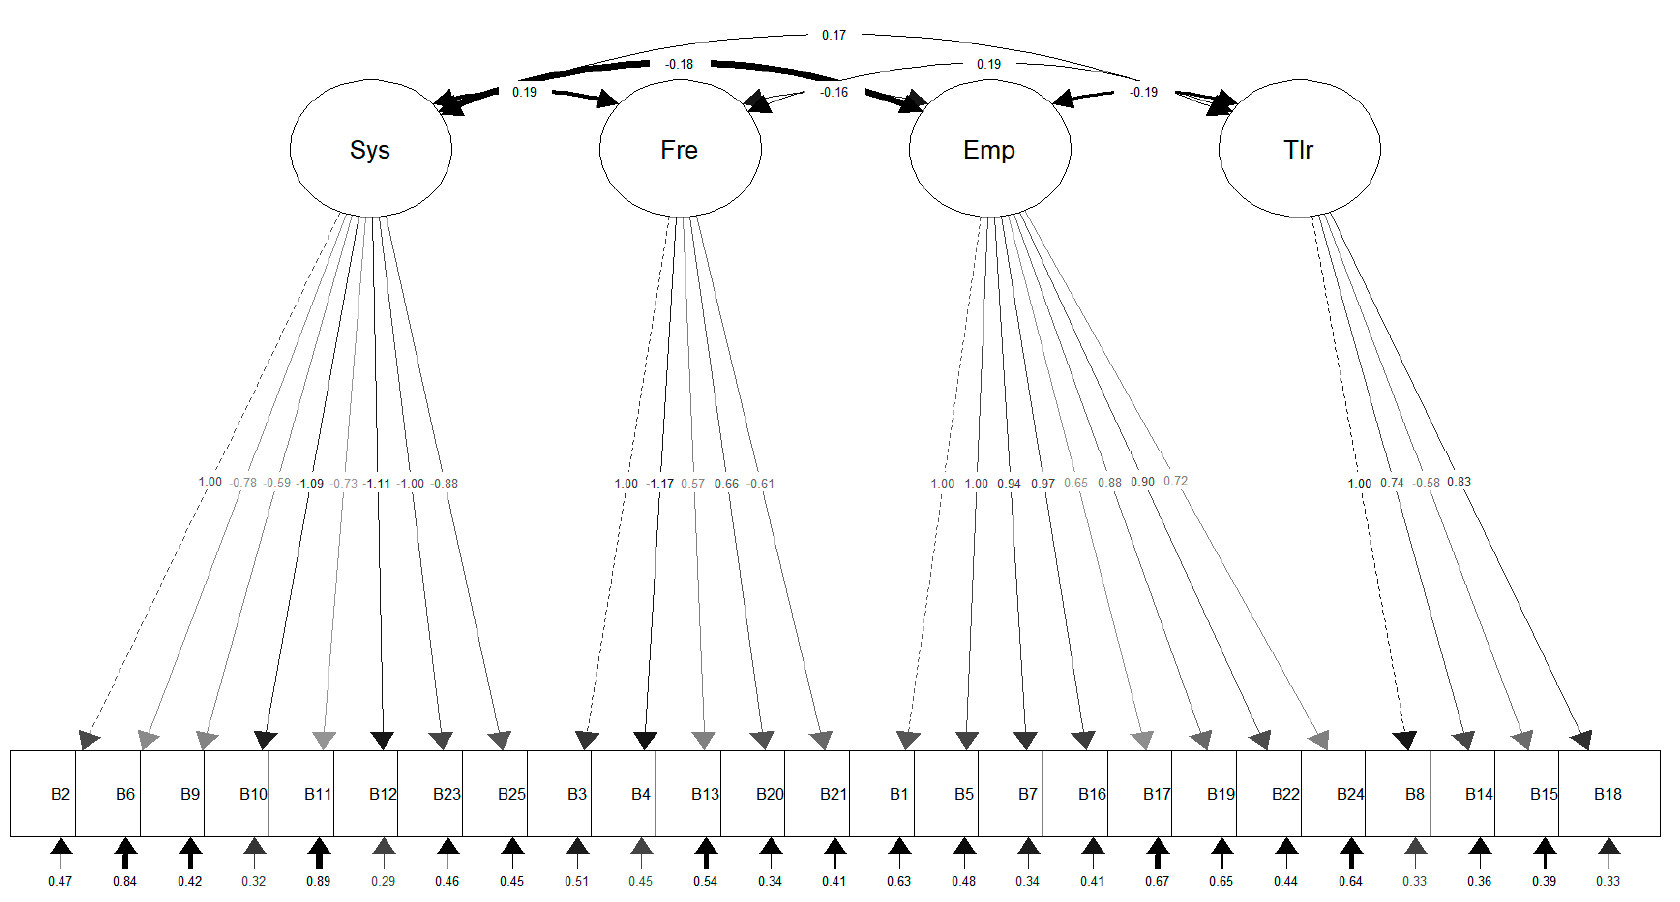
Figure 1. Structural equations diagram of the scale.